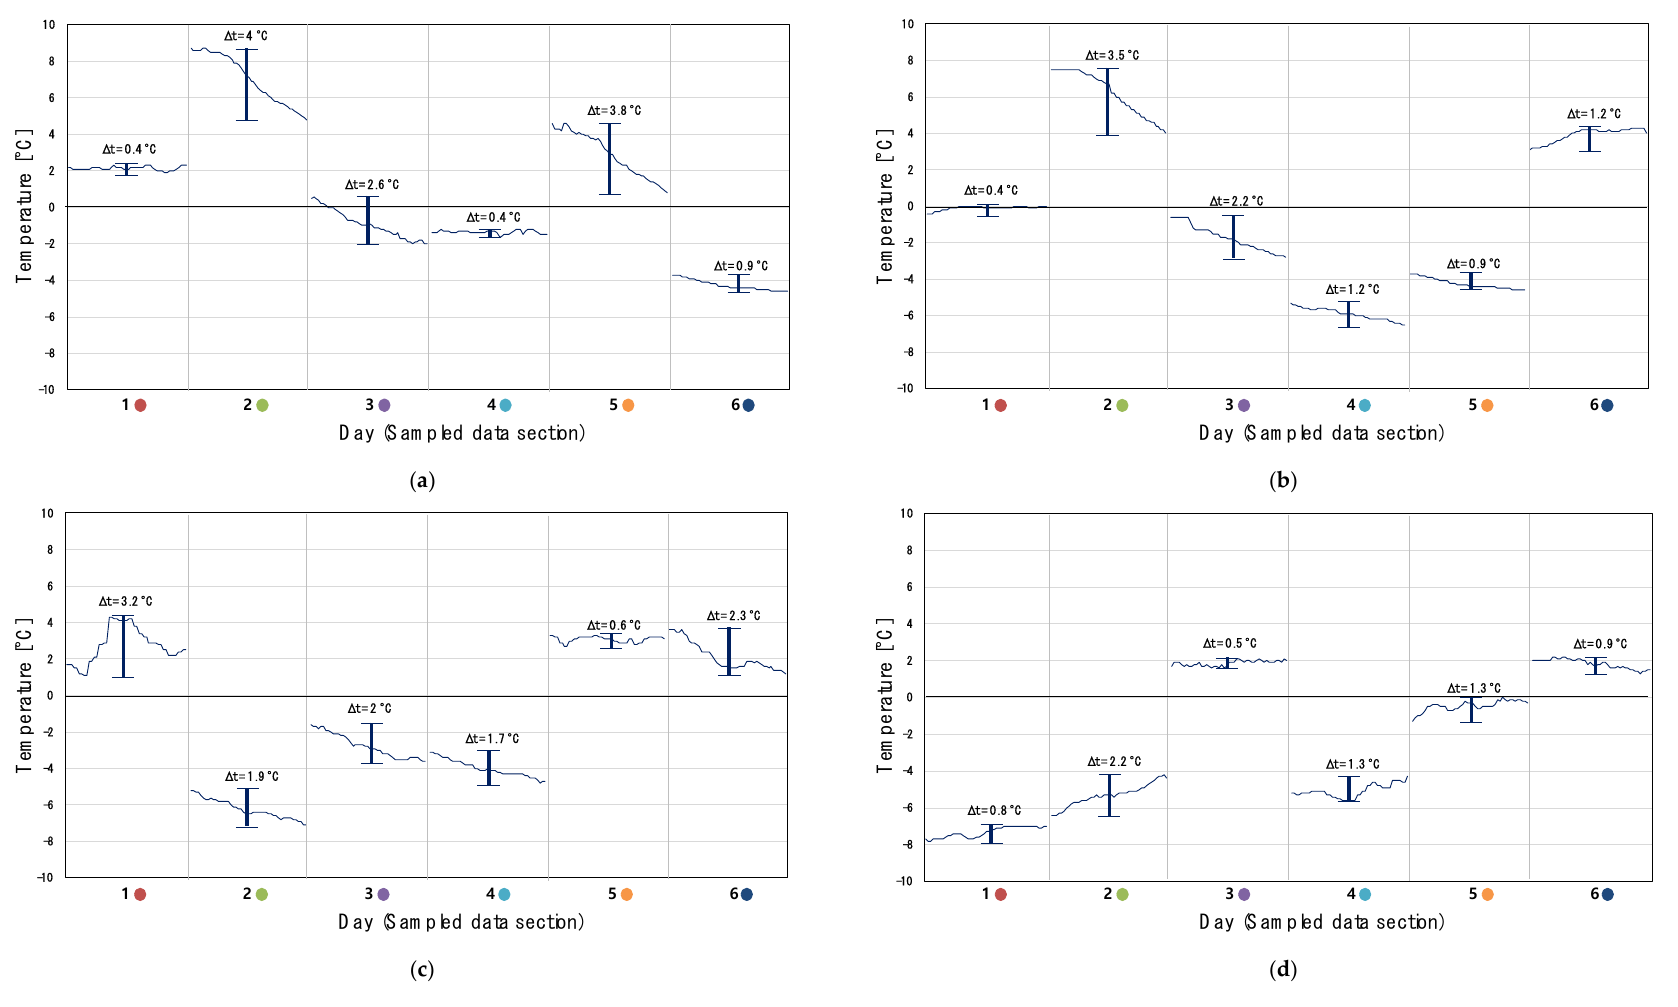
Figure 5. Changes in outdoor temperature: ( a ) Case A; ( b ) Case B; ( c ) Case C; ( d ) Case D.